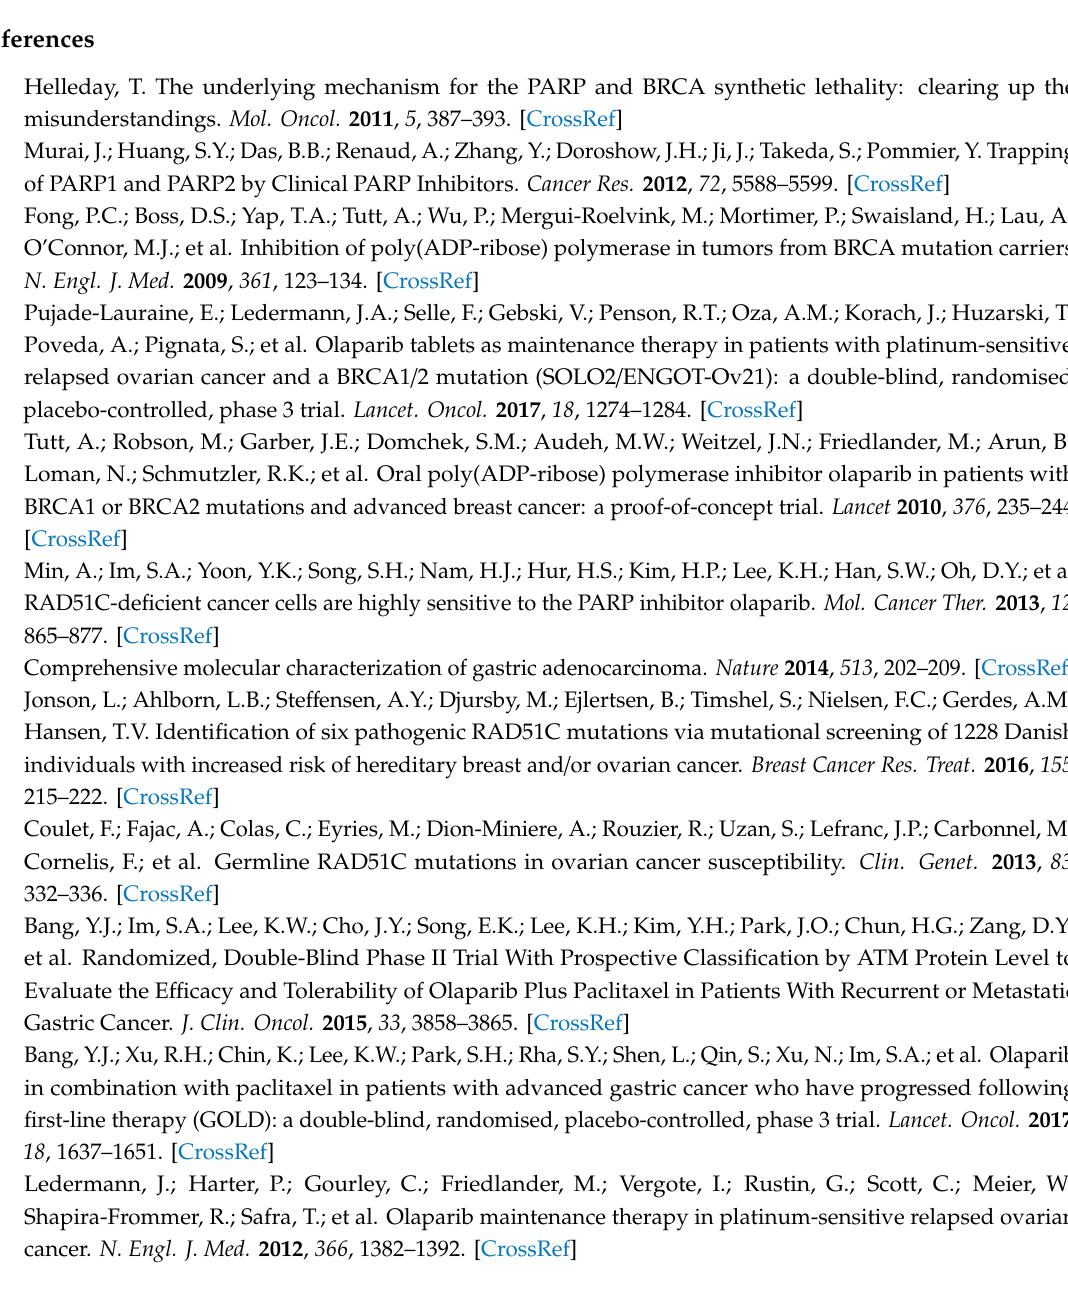
Figure S1. The populations of apoptotic cells following irinotecan or olaparib treatment; Figure S2.